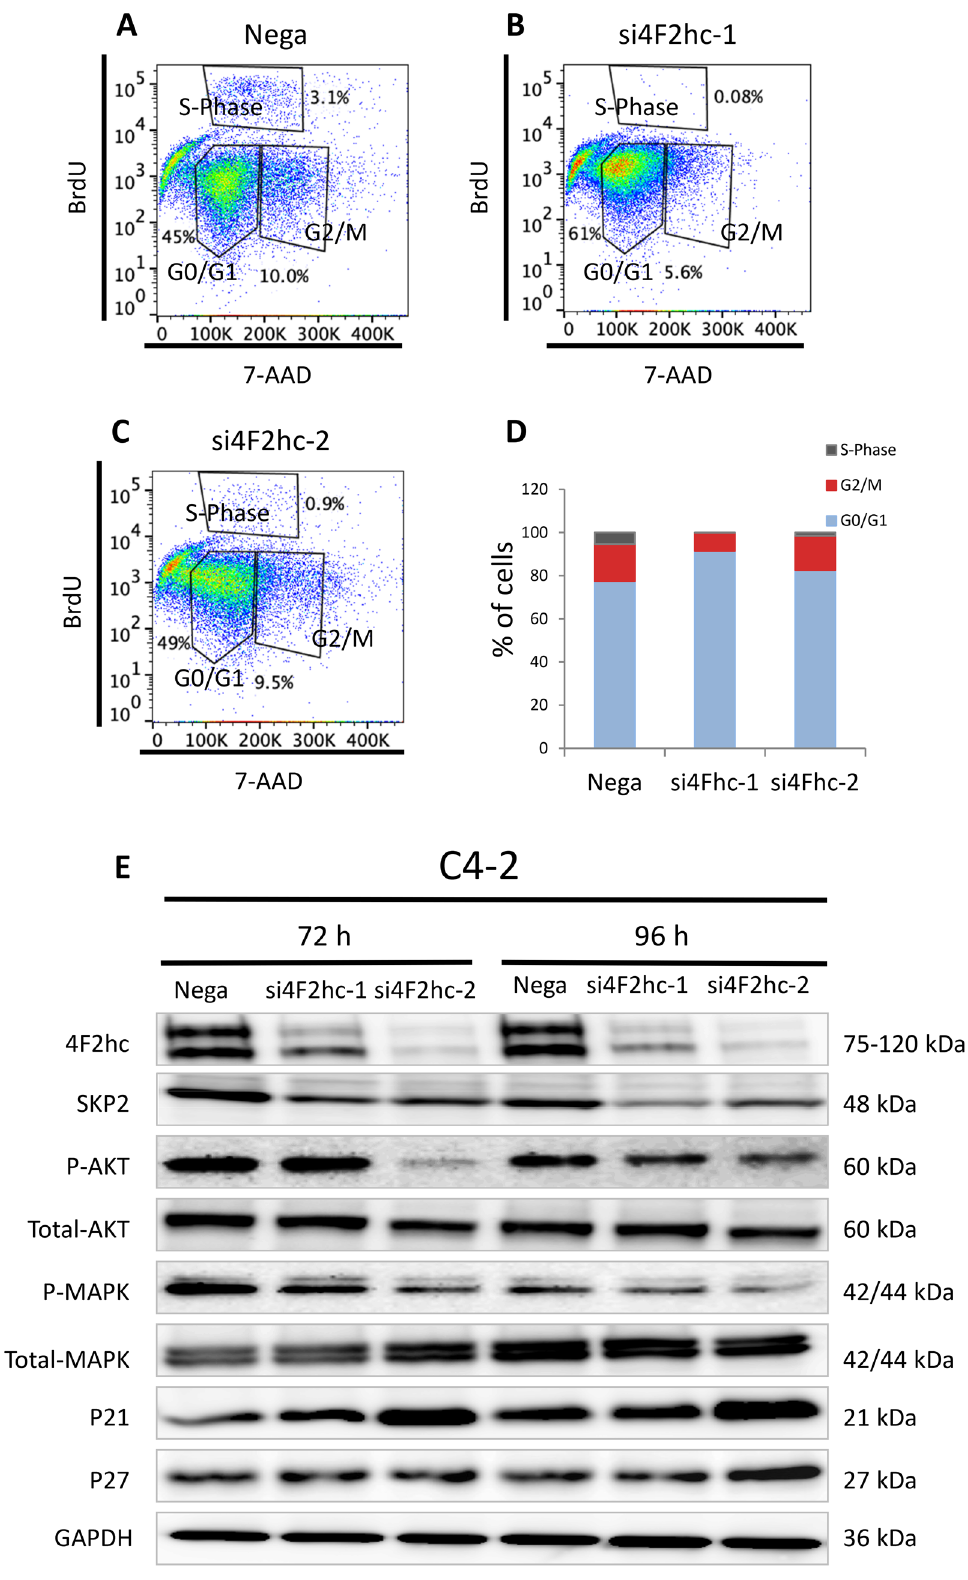
Figure 4. 4F2hc signalling pathway. Cell cycle analysis was performed with si4F2hc (si4F2hc-1 and si4F2hc-2) and compared with a control group ( A to D ). After 72 h or 96 h, si4F2hc (si4F2hc-1 and si4F2hc-2) downregulation of SKP2, phosphorylation of AKT and MAPK, and increased expression of p21 and p27 ( E ). Data represent three independent experiments with similar